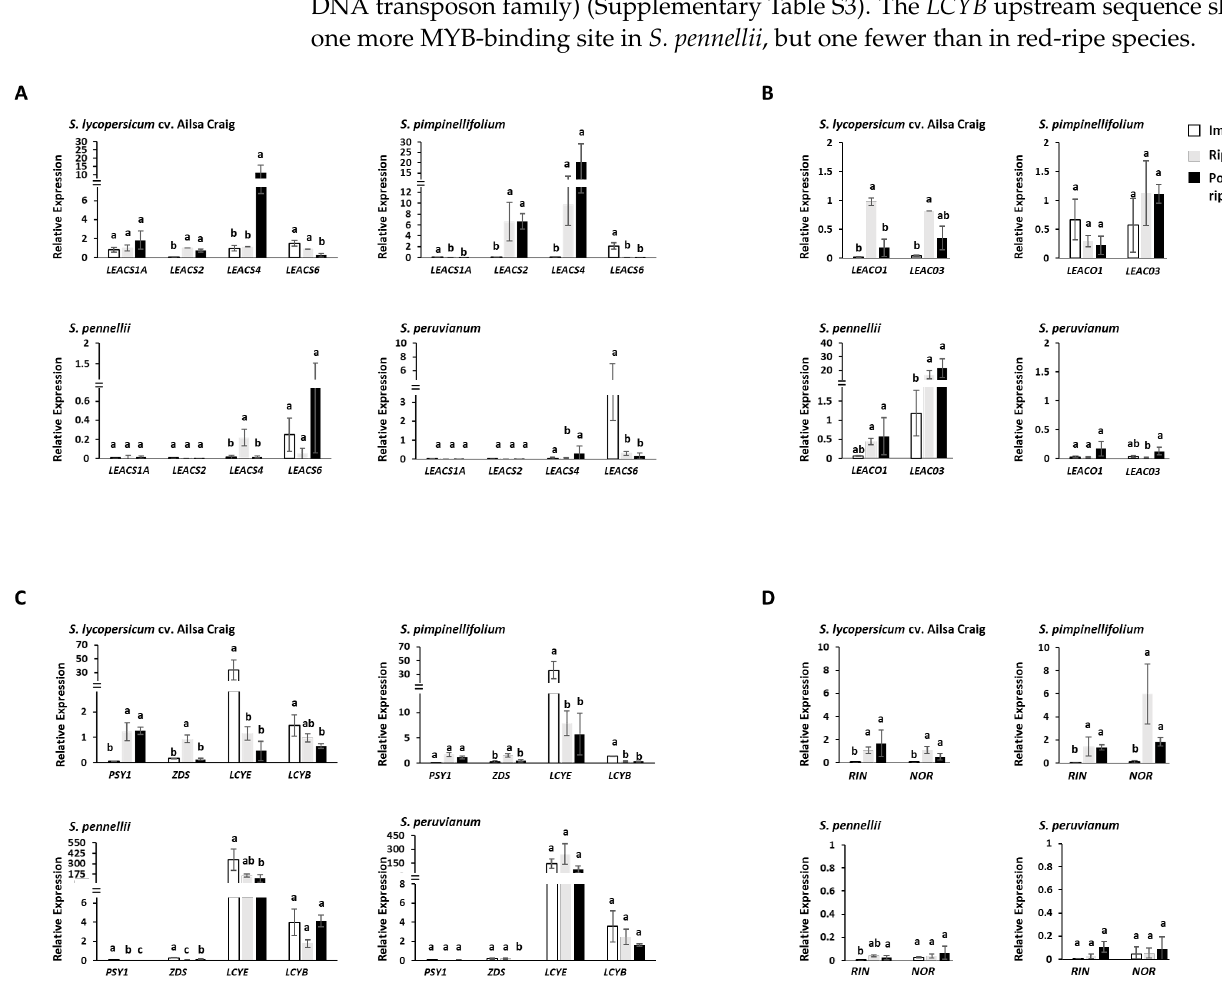
Figure 2. Quantitative RT-PCR analysis of ethylene biosynthetic genes and carotenoid biosynthetic genes. Relative quantification revealing dynamic change in gene expression of LEACS genes ( A ), LEACO genes ( B ), carotenoid biosynthetic genes ( C ), and the key ripening transcription factors ( D ). The white bars indicate the relative expression levels of genes at the immature stage. Gray bars indicate relative gene expression levels at the start of fruit ripening, and black bars correspond to relative gene expression levels at the over-ripening stage. The gene expression level of S. lycopersicum cv. Ailsa Craig at the ripening stage was selected as a reference sample. Significant differences ( p < 0.05) are indicated by lowercase letters. ACS , 1-aminocyclopropane-1-carboxylic acid (ACC) synthase gene; ACO, ACC oxidase genes; PSY1 , Phytoene synthase 1 ; ZDS , z-carotene desaturase; LCYE ,